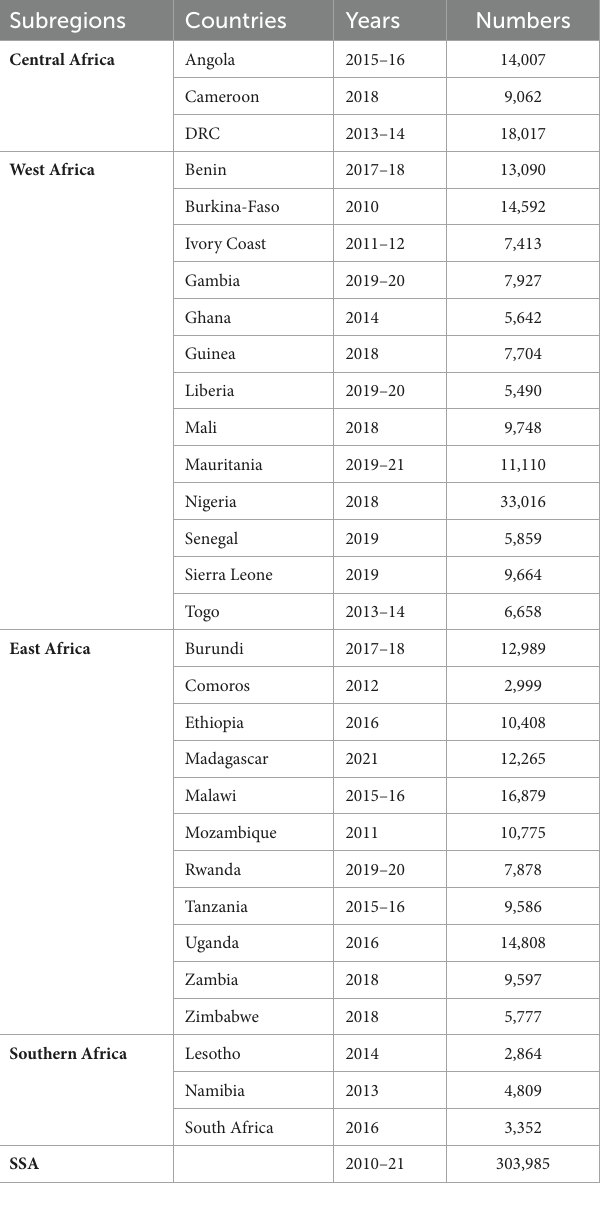
TABLE 1 Distribution of surveyed children by